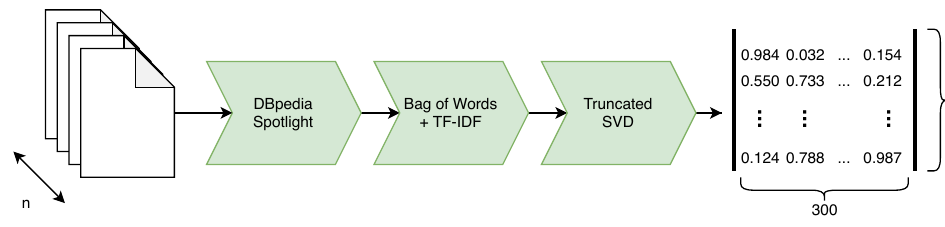
Figure 2. Generation of numerical representations of titles and